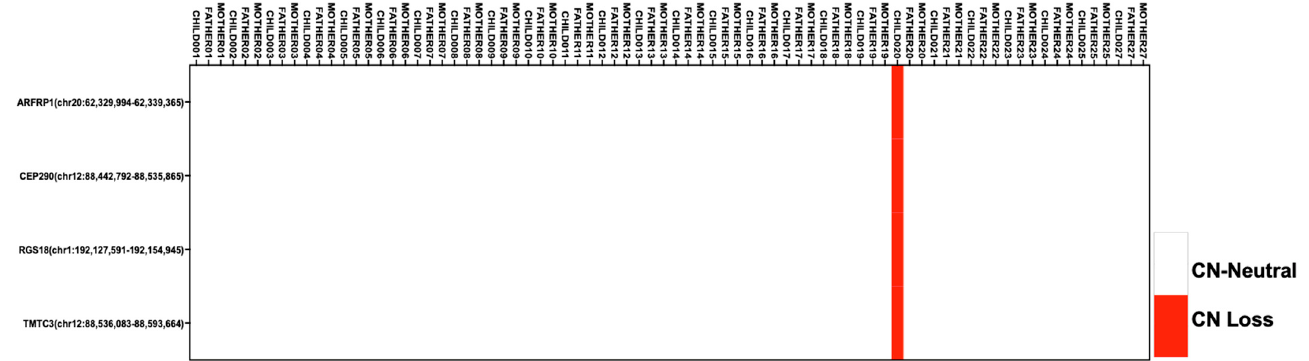
Figure 3. Copy-number variants that are unique to the proband and not present in the general population and control parents. Gene and location are shown for each copy-number event. The white indicates copy neutrality, and the red indicates copy loss. Each CNV is mapped across all trios.